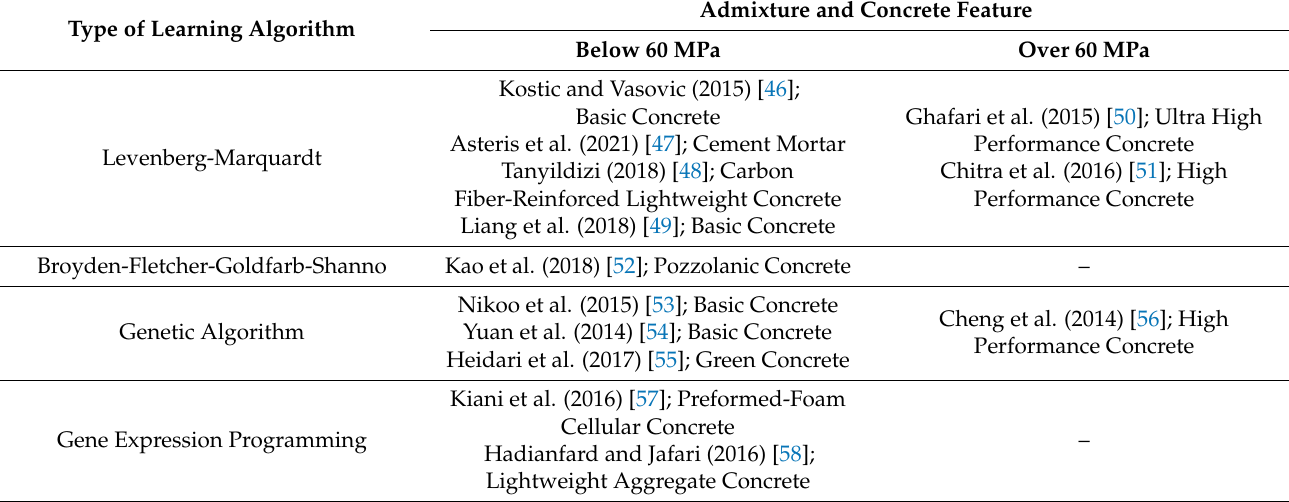
Table 1. Commonly used learning algorithms applied by several researchers to estimate compressive strength. Type of Learning